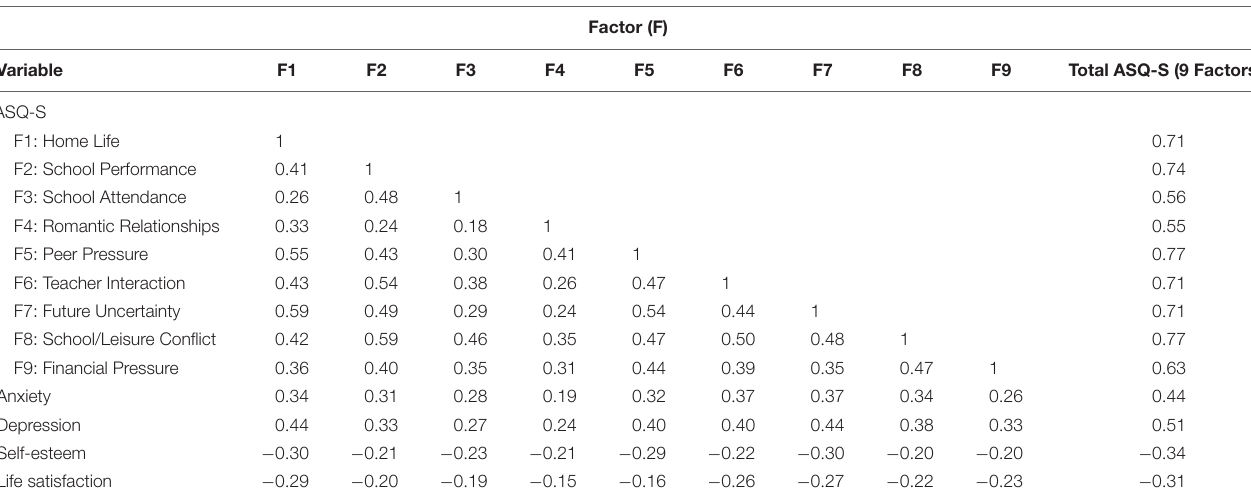
TABLE 5 | Pearson’s correlations between the adolescent stress questionnaire (ASQ-S) scores (9-factors solution) and anxiety, depression, self-esteem and life satisfaction measures.